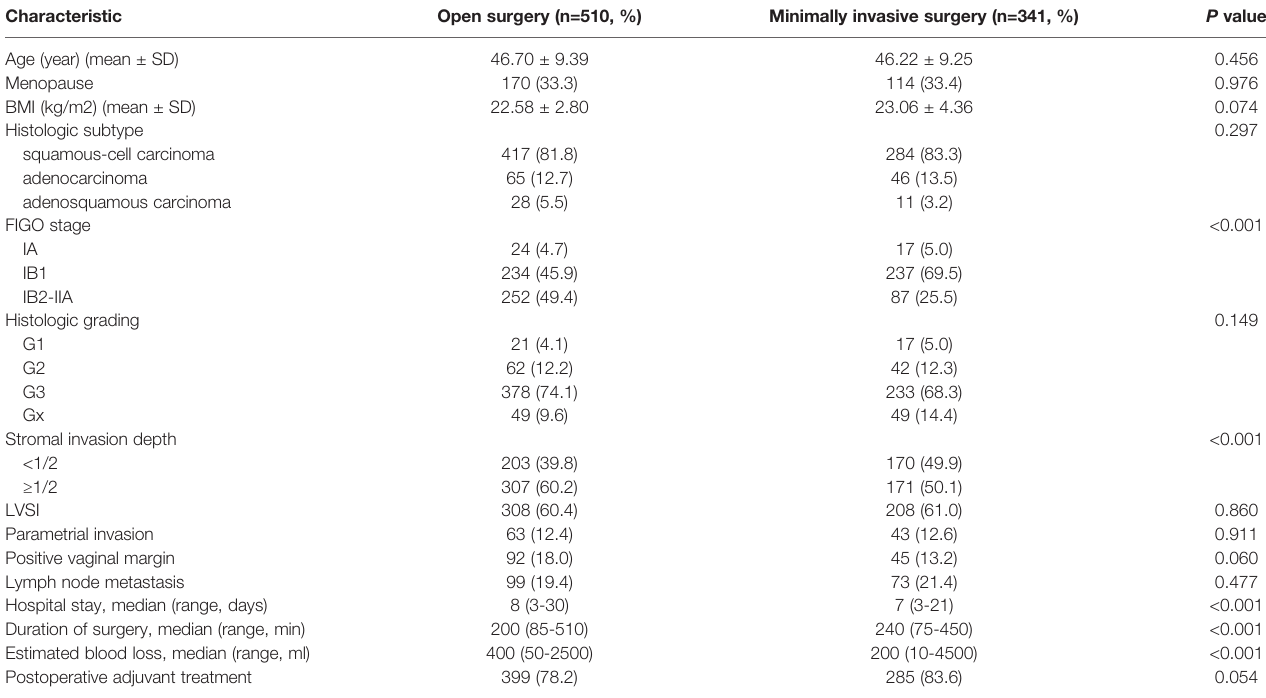
TABLE 1 | General characteristics of the study population strati fi ed by surgical approach.